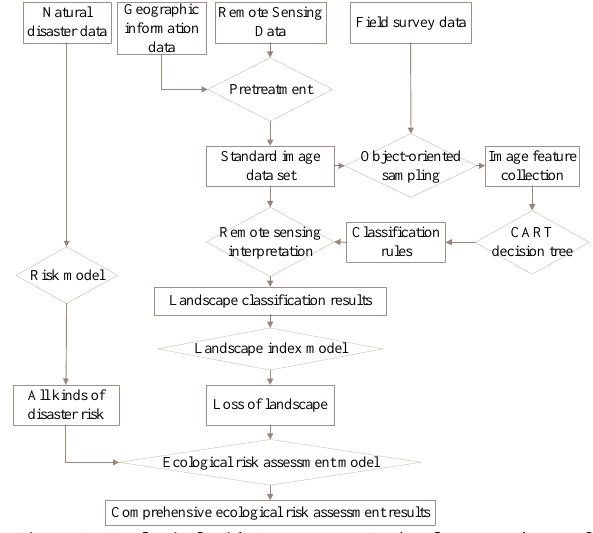
Figure 2. Ecological Risk Assessment Technology Roadmap of Coastal Areas in Guangxi